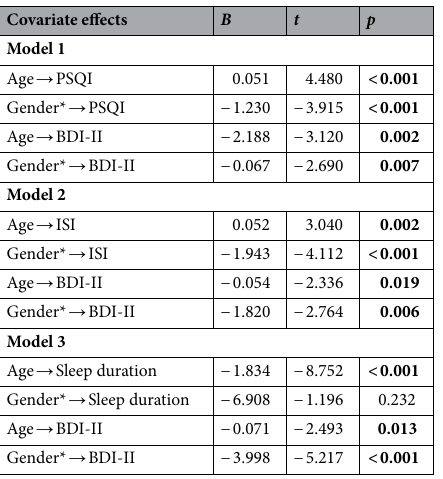
Table 2. Unstandardized effects ( B ), t -value, and significance of the covariates (age, gender) for the three models, including sleep quality (PSQI score; Model 1), insomnia symptoms (ISI score; Model 2), and sleep duration (min; Model 3) as mediators. * Female was used as reference for “Gender” factor. PSQI Pittsburgh sleep quality index, ISI insomnia severity index, BDI-II beck depression inventory-second edition. Significant values are in bold.